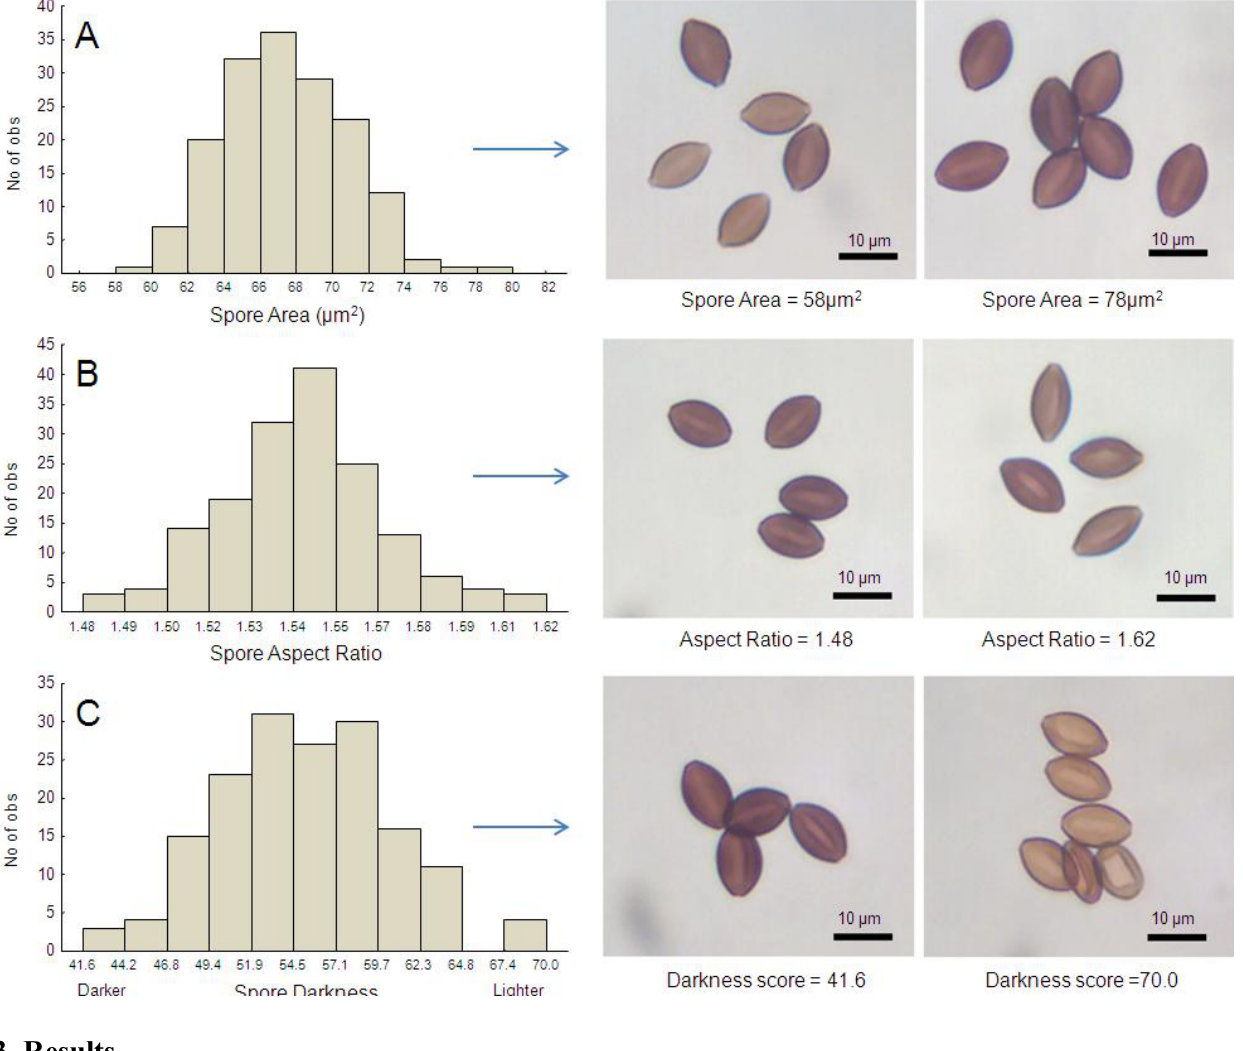
Figure 3. Frequency distribution of OE spore morphometric traits measured in this study, including spore size (2-dimensional area, A ), shape (aspect ratio [length/width], B ) and color (darkness, C ). Images to the right of each graph are photomicrographs of spores that represent the upper and lower range of measurements. Values used to generate histograms are the means per host individual (averaged across 30 spores per